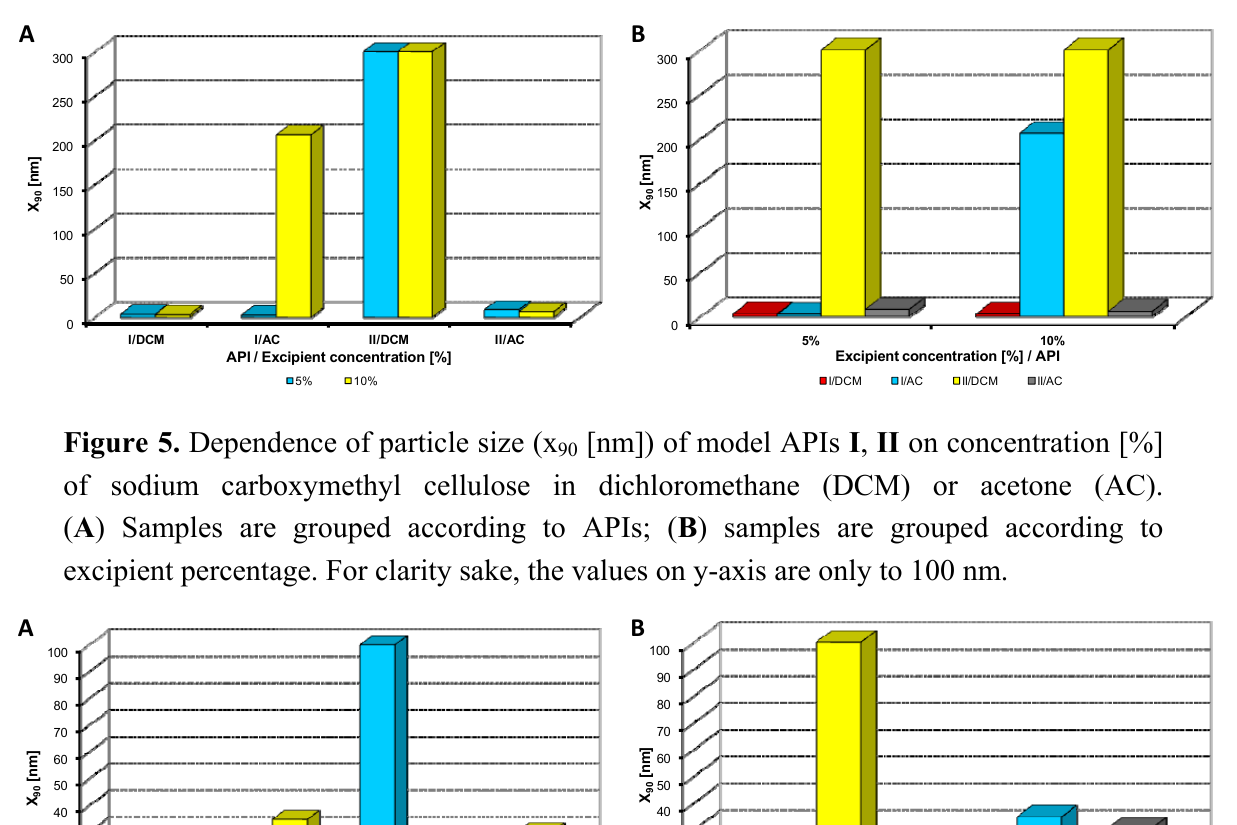
Figure 4. Dependence of particle size (x [nm]) of model APIs I , II on concentration [%] 90 of macrogol 6000 in dichloromethane (DCM) or acetone (AC). ( A ) Samples are grouped according to APIs; ( B ) samples are grouped according to excipient percentage. For clarity sake, the values on y-axis are only to 300 nm.